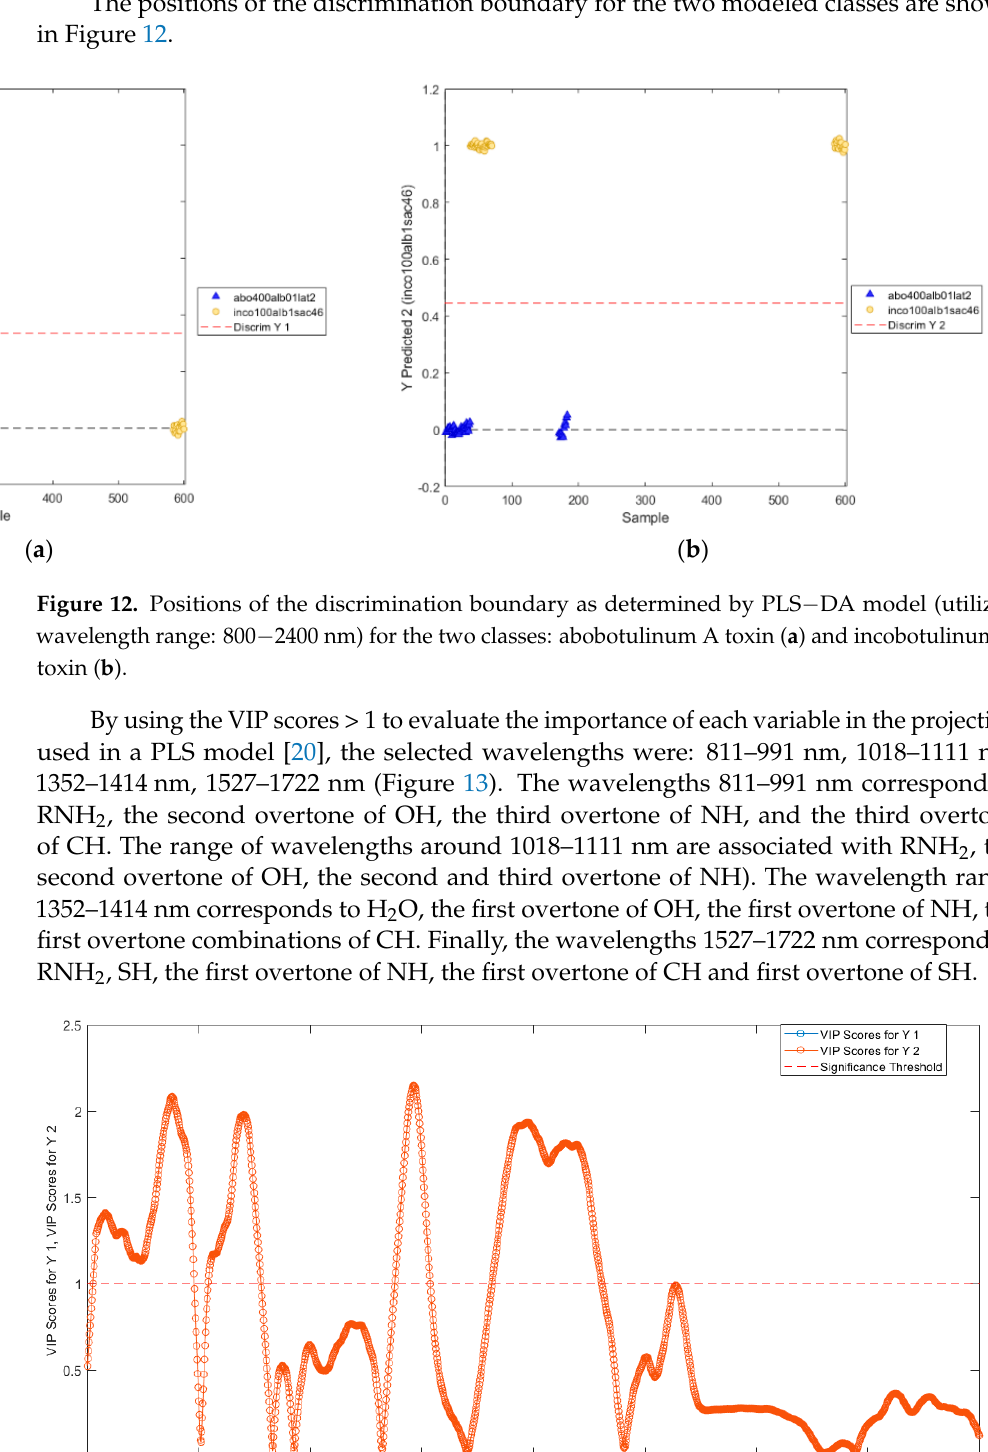
Figure 13. VIP scores determined from PLS − DA model for the two classes of abobotulinum A toxin (VIP scores for Y1) and incobotulinum A toxin (VIP scores for Y2).